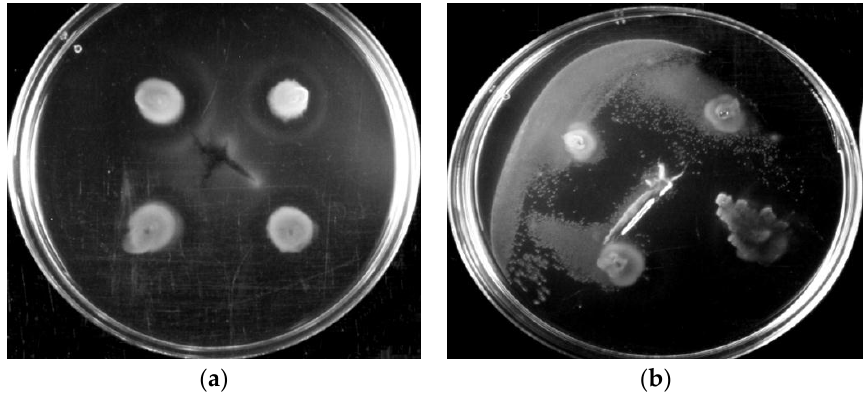
Figure 6. Interactions of mixed drinking water colonies with and without Methylobacterium addition after 12 h of incubation: ( a ) Four mixed drinking water colonies and ( b ) four mixed drinking water colonies with 1% Methylobacterium inoculated.